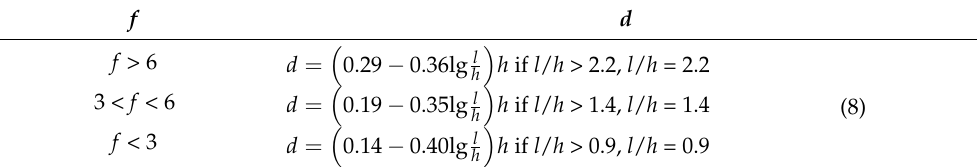
Table 4. Displacement angle ( β s ) of loose